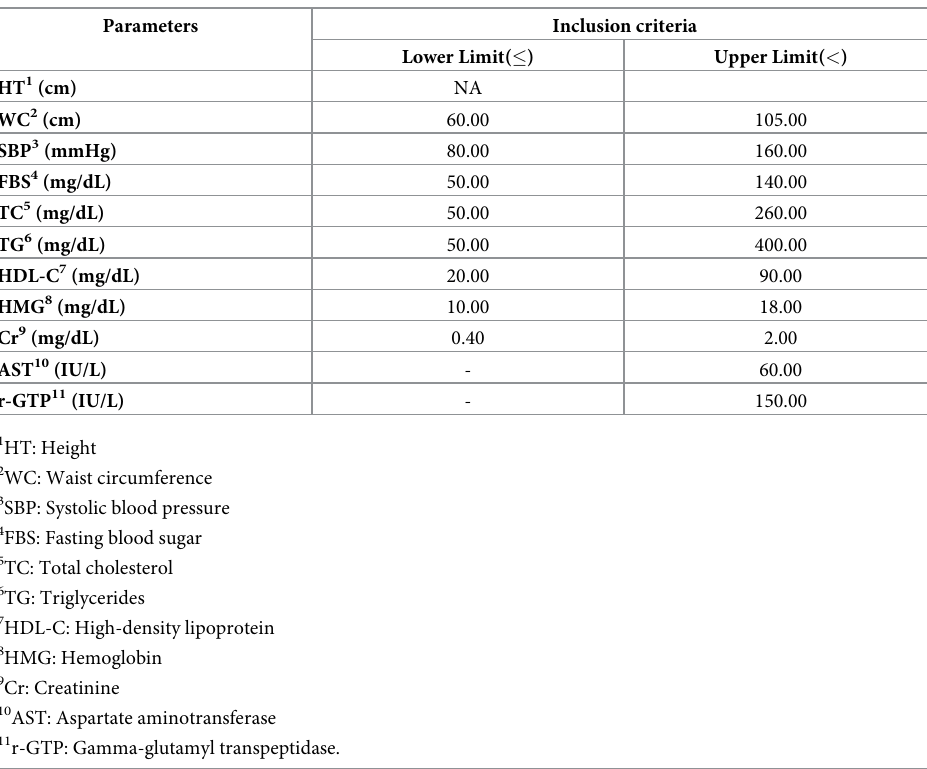
Table 1. Inclusion criteria for the study